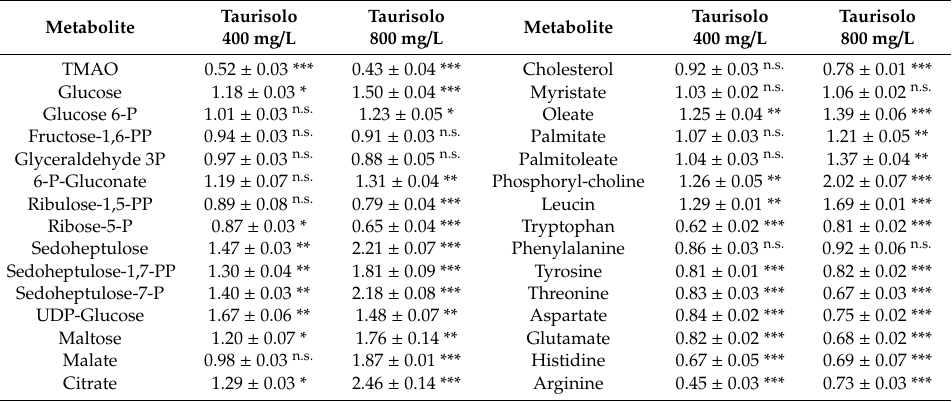
Table 1. Taurisolo reprograms the metabolism of HuH7